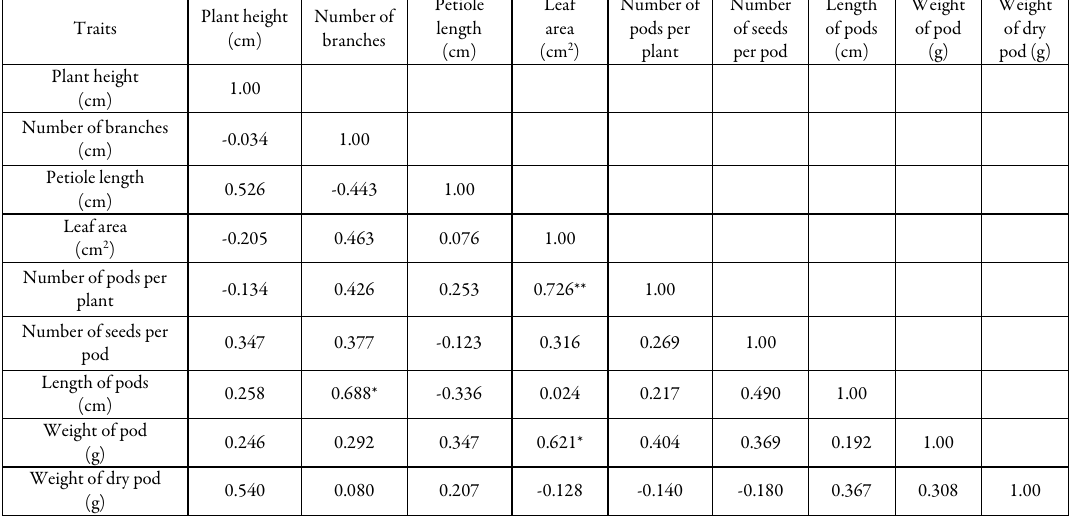
Number of Number Length Weight Weight Leaf pods per of seeds of pods of pod of dry area plant per pod (cm) (g) pod (g) (cm 2 )